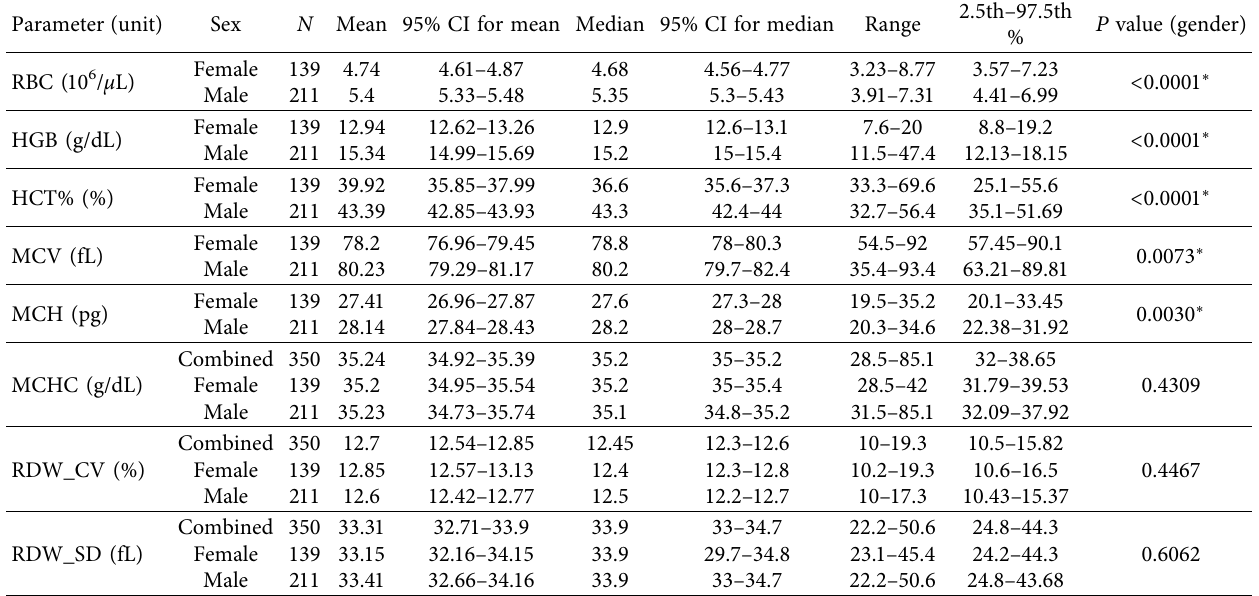
Table 3: Calculated hematological (RBC and RBC indices) reference intervals for the screened population. Parameter (unit)